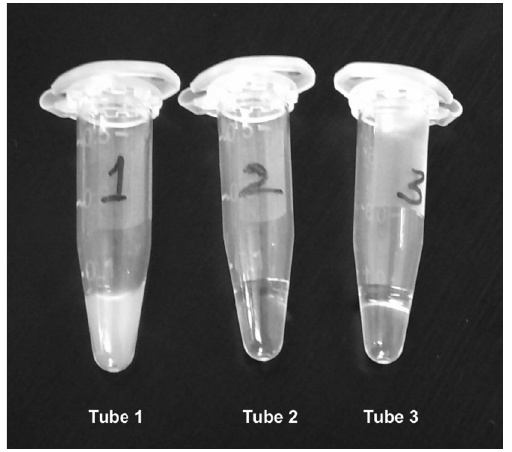
Figure 7. Visual turbidity detection of LAMP amplification. Clear negative samples (Tube 2: MTB control and Tube 3: No template control) can be visually differentiated from the positive sample (Tube 1: ML DNA) showing turbidity.